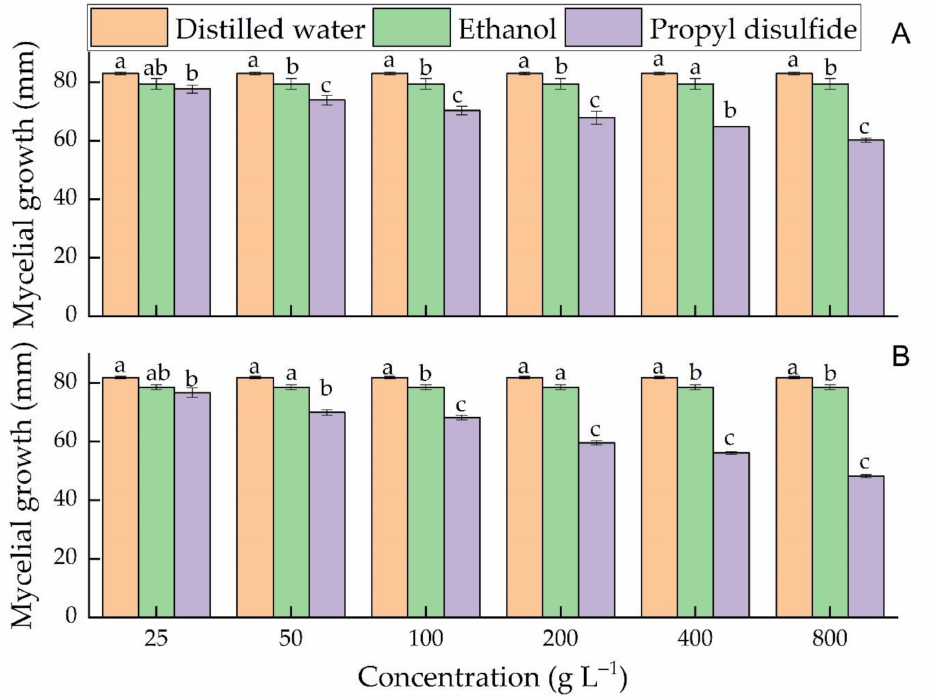
Figure 3. Effects of different concentrations of propyl disulfide in the vapor phase assay on the mycelial growth of C. acutatum at day 14 ( A ) and C. gloeosporioides at day 10 ( B ). Different small letters in each concentration represent a significant difference among the treatments. The mycelial growth presented is the mean of five replicates ± SD at p ≤